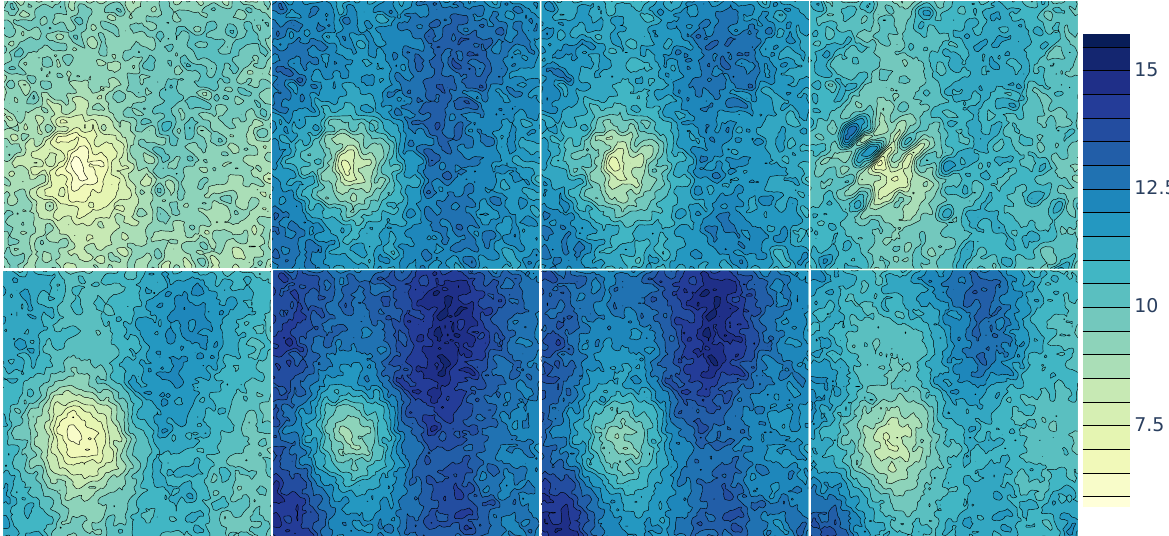
Figure 11. Standard deviation ( mm ) of predictions for δ = { 32,64 } , s = 4 for a 10 m × 10 m pasture for L out = { 1,6,11,15 } , respectively. We observe lower uncertainties at the peaks of the pasture due to its lower variability over time. Input sequence to the DeepPaSTL network L in = 15 is 01 April 2019 to 27 May 2019 and output prediction L out = 15 every 4 days. The uncertainty estimates effectively correlate to 1,24,44,60 days in the future during the peak pasture growth time of 31 May 2019 to 26 July 2019. ( Bottom ) δ = 32 We observe the lower quantization of the pasture has higher uncertainty in its prediction when less spatial information is available for processing especially when pasture dynamics are high. ( Top ) δ = 64 has smaller prediction uncertainties for the same set of